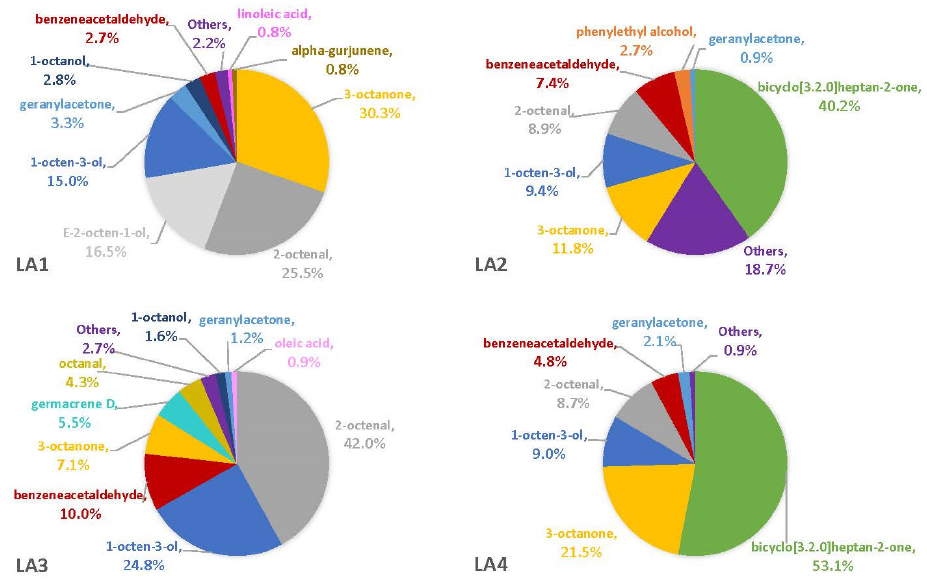
Figure 2. Average percentages (over three replicates) of VOCs contributing to total headspace profile of each Aspergillus strain while growing on MGA medium.